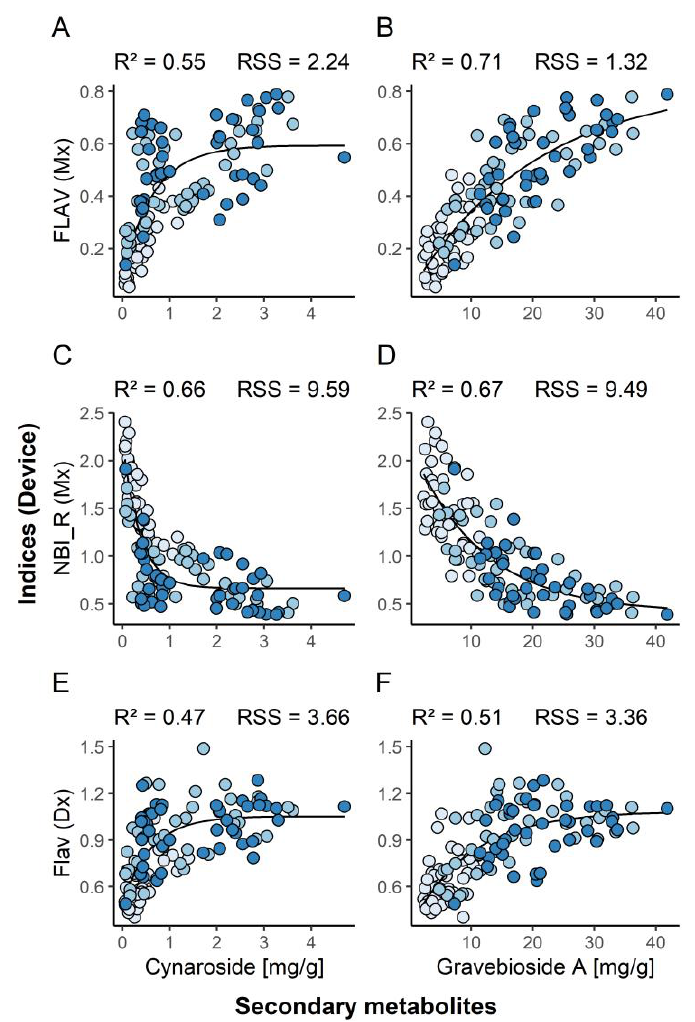
Figure 3. Exponential regression between indices of non-invasive devices and leaf secondary metabolite concentrations in bell pepper leaves, determined via HPLC. Contents of cynaroside and graveobioside A correlated with FLAV (Mx) ( A ), ( B ), NBI_R (Mx) ( C ), ( D ), and Flav (Dx) ( E ), ( F ). Color of points represents leaf age (Leaf 4, 10, and 12 as counted from the base, with darkest colors for youngest leaves). Lines indicate exponential regressions ( n = 60). RSS, residual sum of squares.